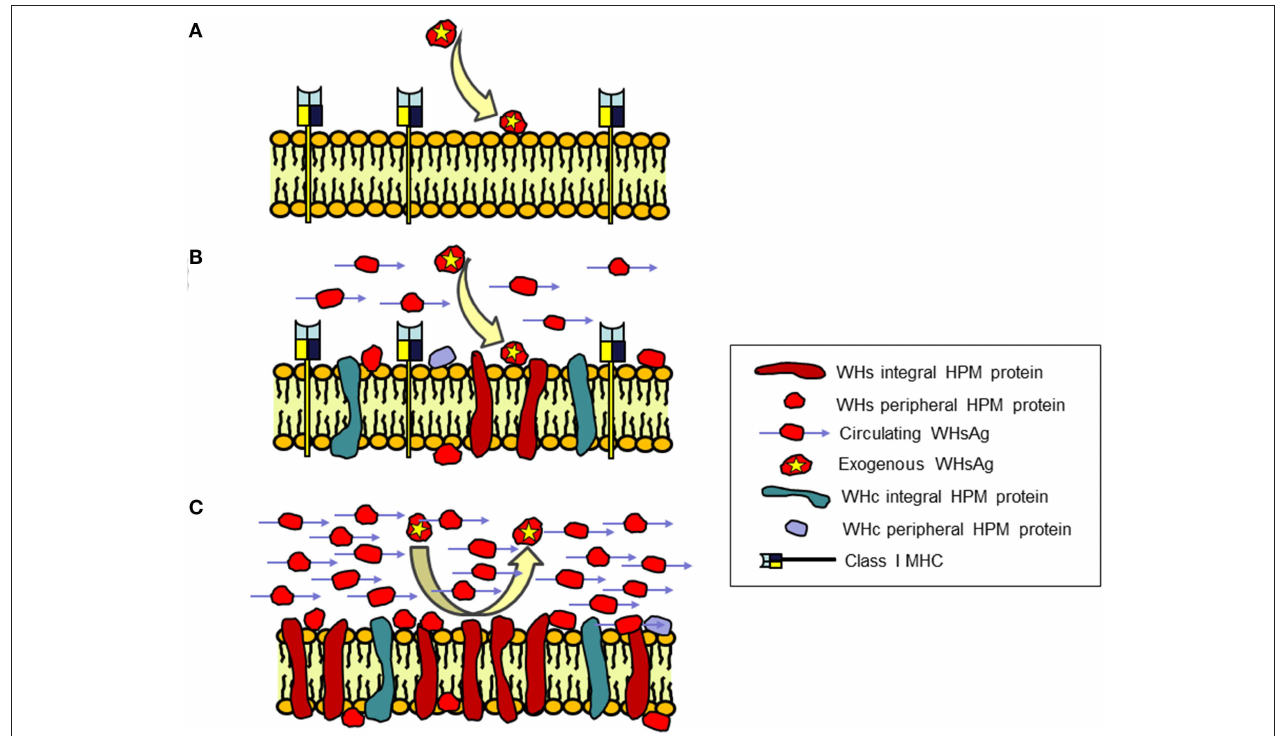
FIGURE 5 | Schematic presentation of the concept of an immune protective barrier at the surface of hepatocytes in chronic WHV infection created by virus envelope (WHs) proteins associated with hepatocyte plasma membranes (HPM) that coincides with depletion of class I MHC on the membranes. HPM from (A) Healthy, WHV-negative woodchucks; (B) WHV-infected animals with acute hepatitis (AH), and (C) WHV-infected animals with chronic hepatitis (CH). CH in contrast to AH is characterized by irreversible incorporation of large (saturating) quantities of WHs proteins into HPM lipid bilayer and presence of WHs reactivity loosely associated with HPM structure behaving as peripheral membrane protein. In addition, CH occurs in the context of large quantities of circulating virus envelope proteins carrying WHs antigenic specificity (WHsAg) and inability of HPM to bind exogenous purified WHsAg in contrast to HPM from healthy woodchucks and animals with AH. WHV core (WHc) proteins are also incorporated as integral and joined with HPM as peripheral membrane proteins, however there are no differences between AH and CH in their HPM quantities and susceptibility to removal by agents dissociating HPM. In addition, HPM from CH are voided of class I MHC presence in contrast to HPM from acutely infected and healthy animals. Together, the concept assumes that WHs proteins incorporate at saturating quantities into hepatocyte surface membranes in combination with large amounts of circulating WHsAg and absence of class I MHC presentation at the membranes form an immune protective barrier that shelters infected hepatocytes from immune elimination. For details see Michalak and Churchill ( 115), Michalak et al. (116, 117), Michalak and Lin (118), Michalak et al. (119), and Wang and Michalak (